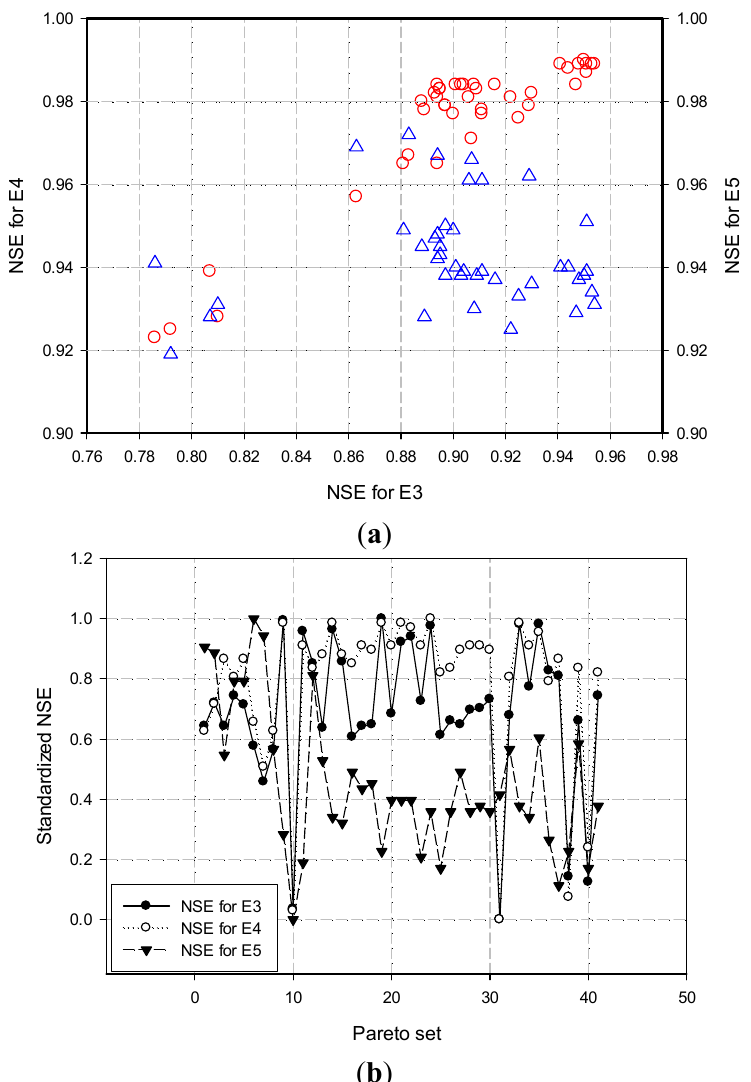
Figure 6. NSEs for E3, E4, and E5 with 41 parameter sets: ( a ) scatter plot between two NSEs (red circles for E3 vs. E4 and blue triangles for E3 vs. E5) and ( b ) standardized NSEs along the 41 parameter